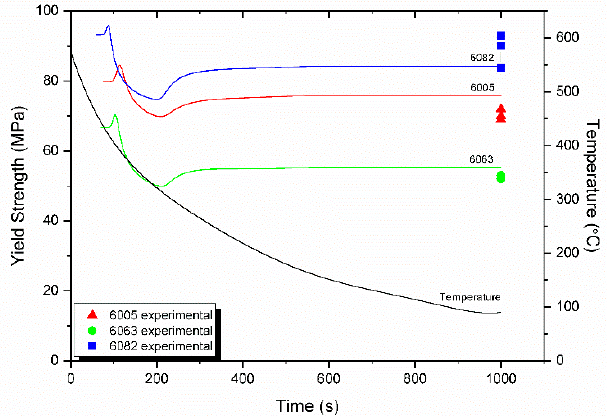
Figure 17. Evolution of the yield strength during homogenization cooling and comparison with experimental data for 6063, 6005, and 6082 alloys.